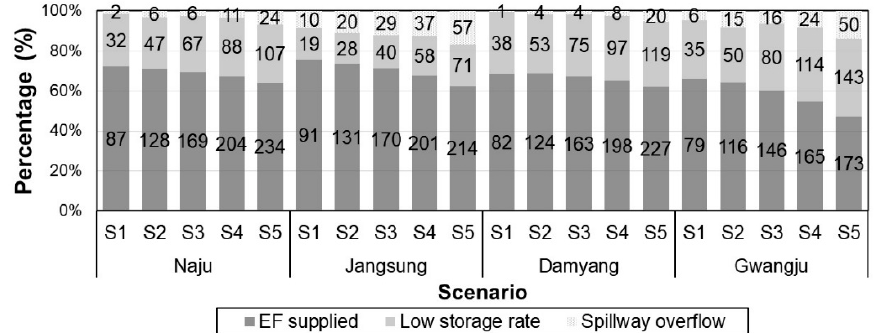
Figure 6. Lengths of periods when water is available from the reservoirs.